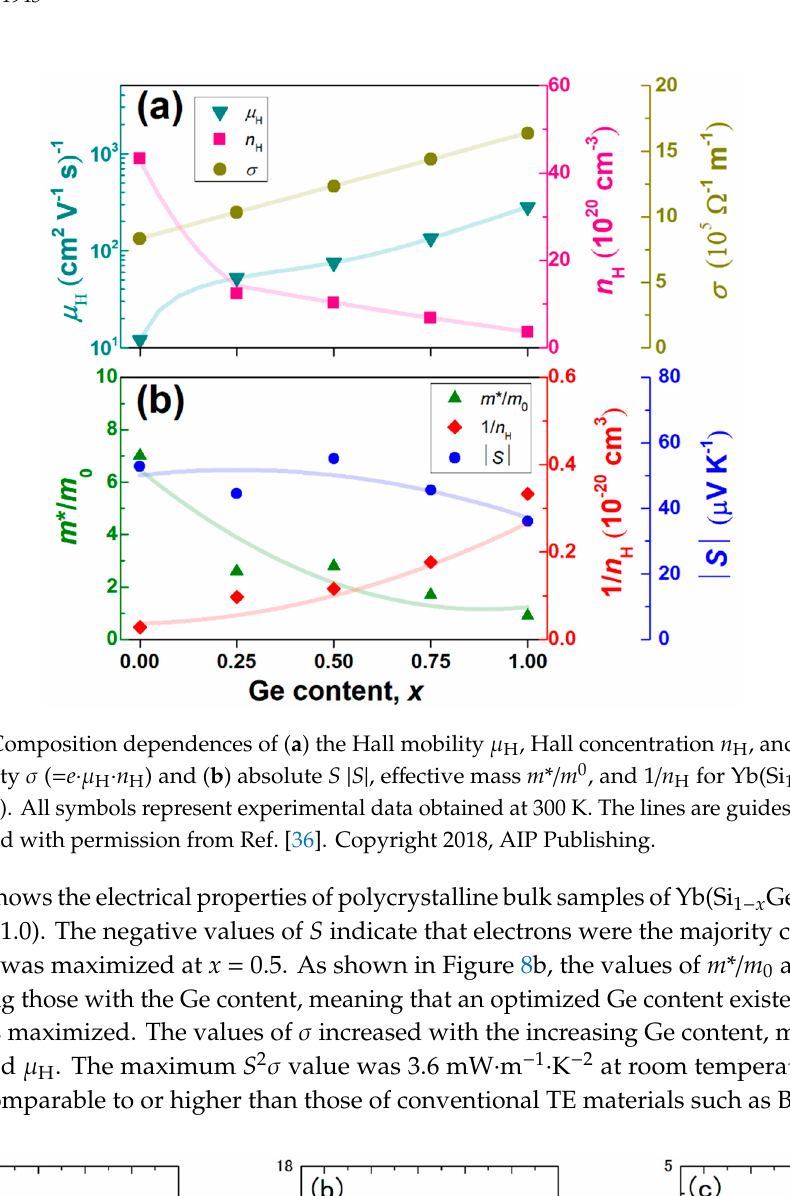
Figure 10. Temperature dependences of ( a ) total thermal conductivity κ , ( b ) lattice thermal conductivity κ lat , and ( c ) dimensionless figure of merit zT for polycrystalline bulk samples of Yb(Si 1 − x Ge x ) 2 −δ ( x = 0, 0.25, 0.50, 0.75, and 1.0). Reproduced with permission from Ref. [36]. Copyright 2018, AIP Publishing. 5. Summary In this review, recent research toward the development of high-efficiency eco-friendly Si-based TE materials was summarized. When a melt of highly P-doped Si is cooled from the α -phase, Si–P binary precipitates form naturally in the Si matrix, yielding nanostructured bulk Si. The nanoscale precipitates reduce κ lat without significantly affecting the electron transport properties, thus enhancing zT . In addition to this natural nanostructuring procedure, our group has proposed the rapid-solidification MS method to synthesize Si–metal silicide nanocomposites. At the eutectic